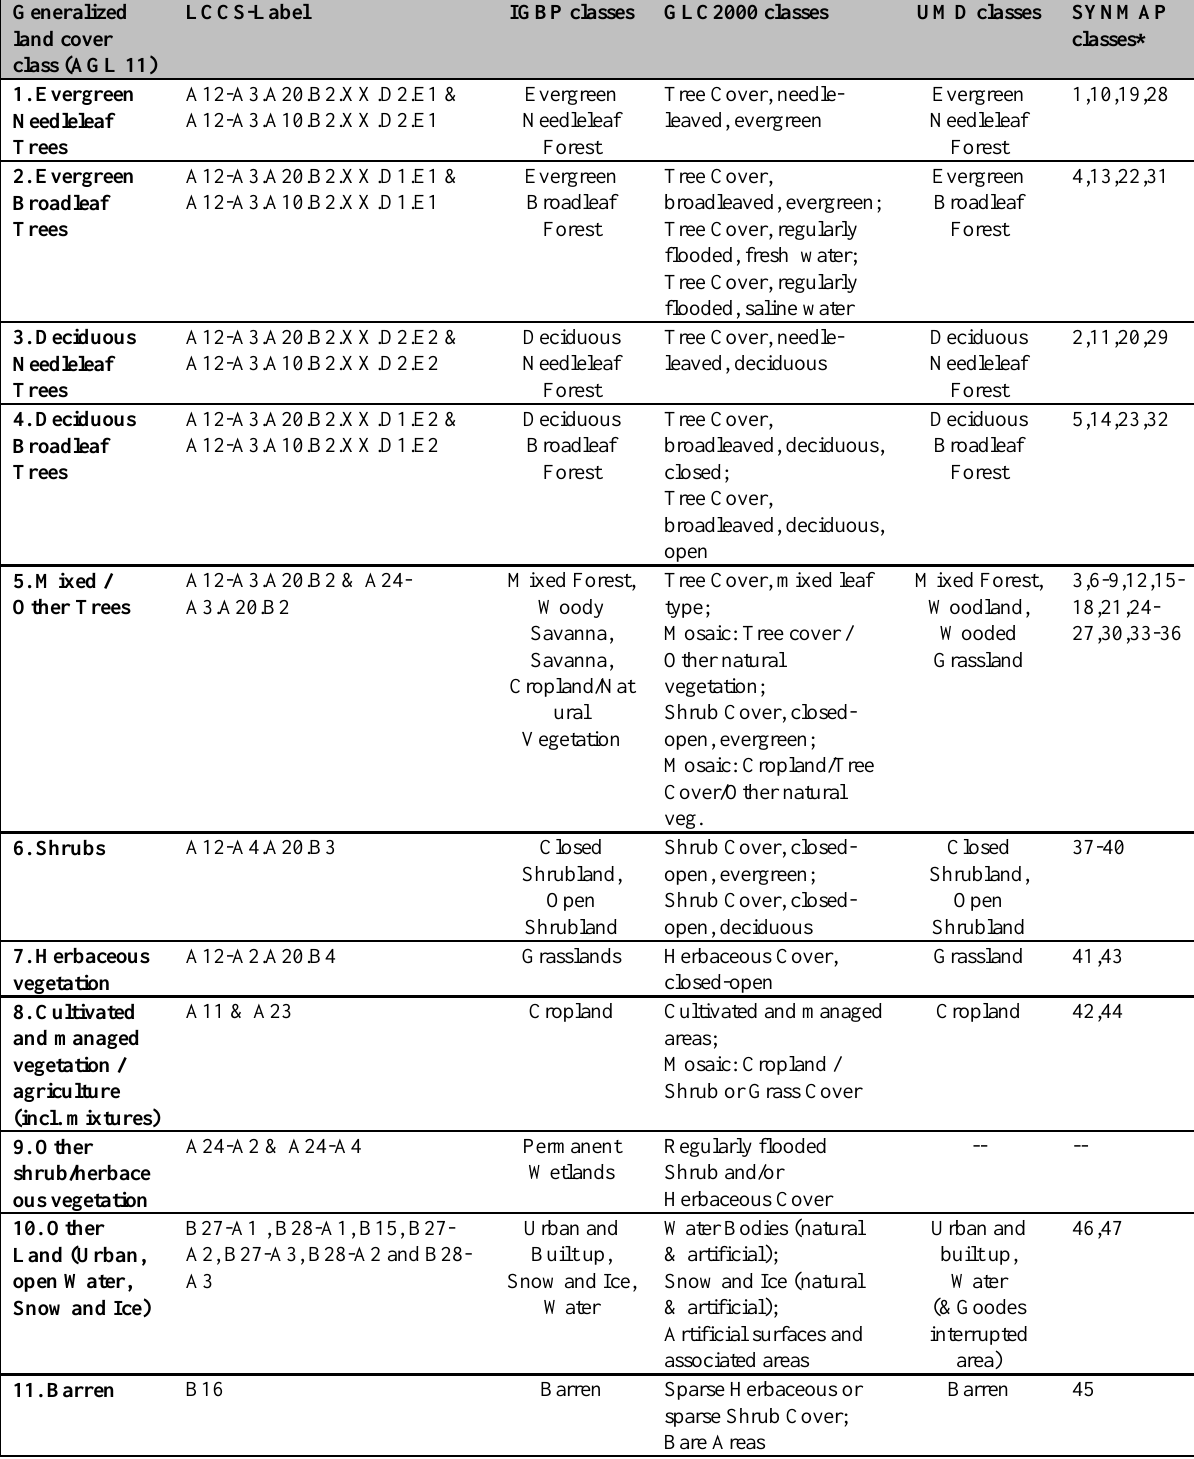
Table 2. Different GLC legends (for SYNMAP classes see Jung et al